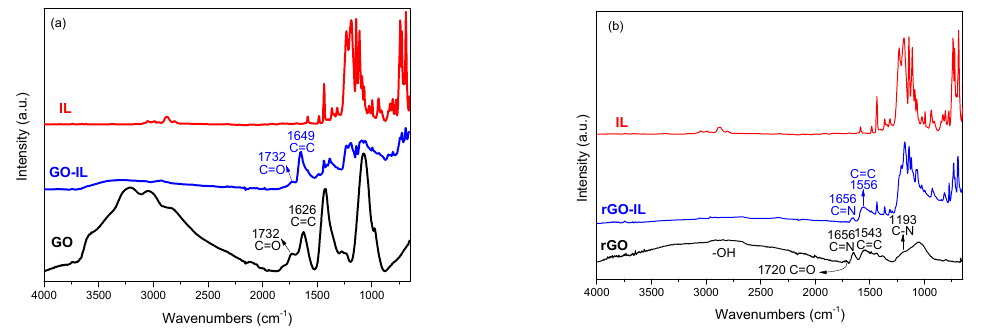
Figure 4. ATR FTIR spectra of GO, IL, GO-IL ( a ) and rGO, IL, rGO-IL ( b ).